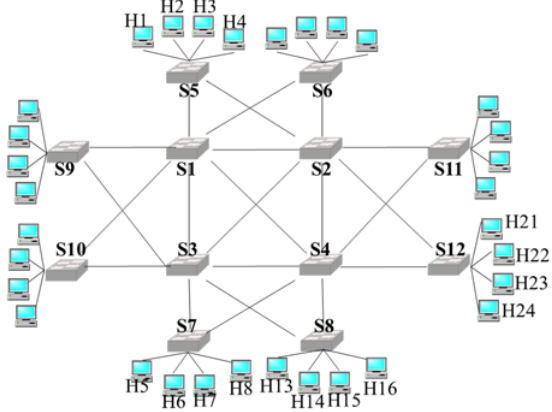
Figure 2. Mininet topology for simulation.